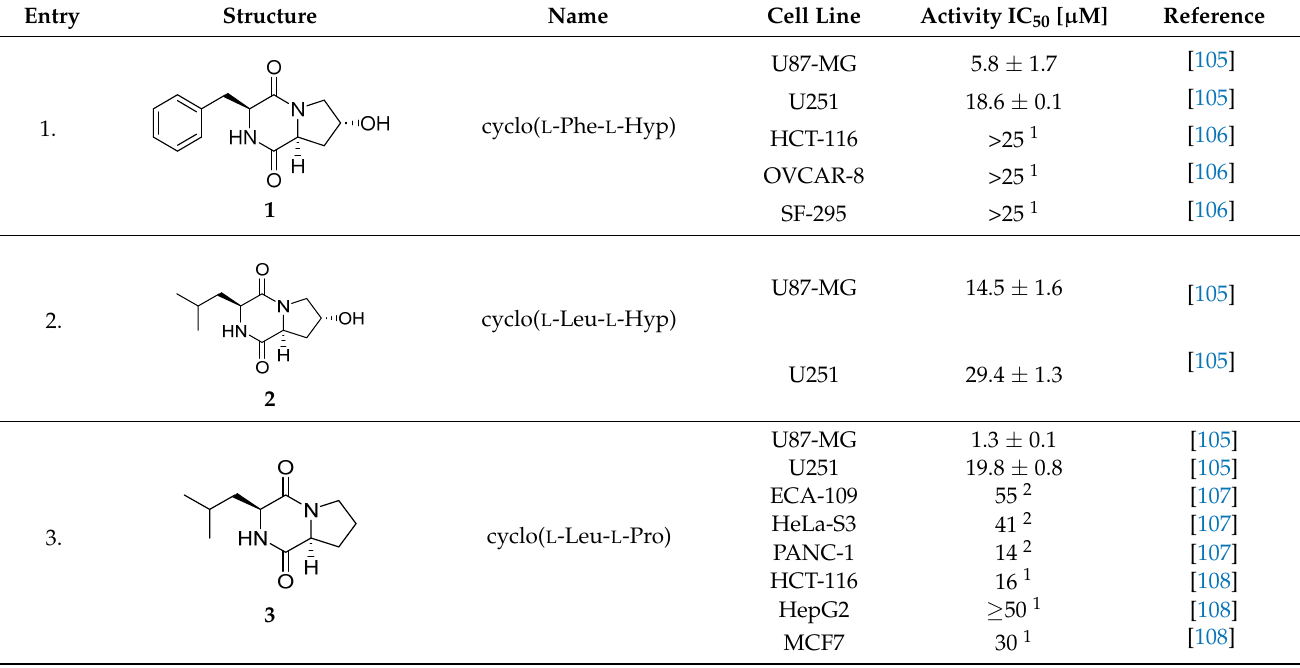
Table 1. Bi ‐ and tricyclic proline ‐ based DKP with simple side Table 1. Bi- and tricyclic proline-based DKP with simple side chains.